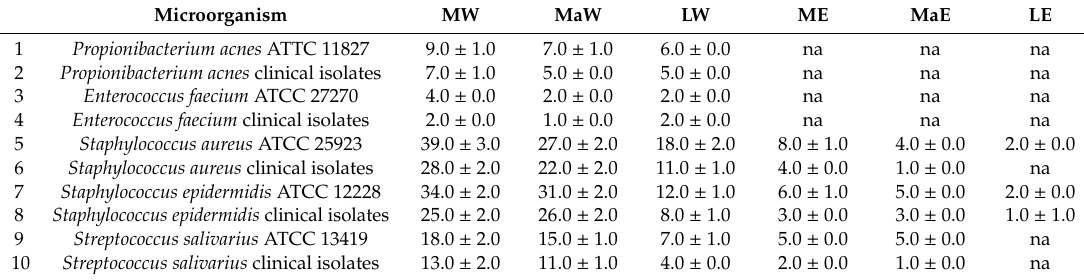
Table 5. Inhibition growth area [mm] of selected microorganisms by tested hop